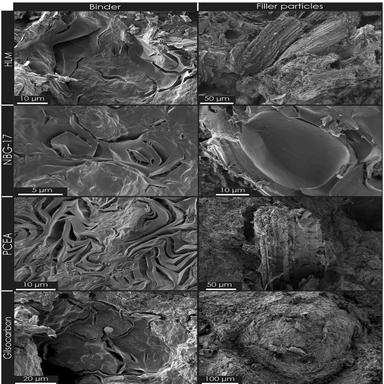
Fractography SEM micrographs of the binder and filler of medium-fine graphite grades.